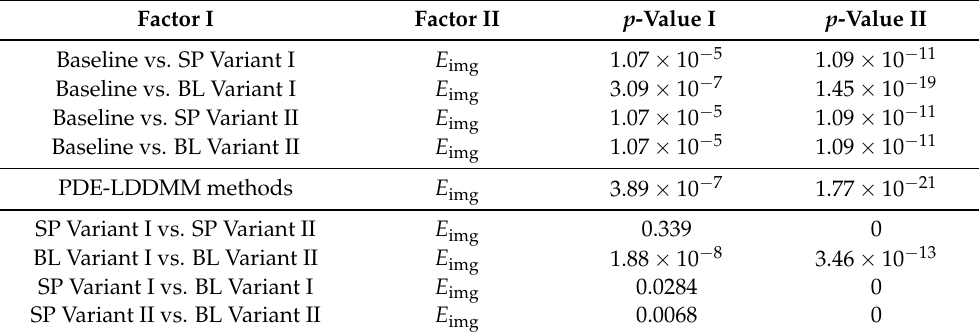
Table 1. NIREP16. Multi-resolution experiments and Gauss-Newton-Krylov optimization. Results of ANOVA tests for the effects of method and image similarity metric selection.